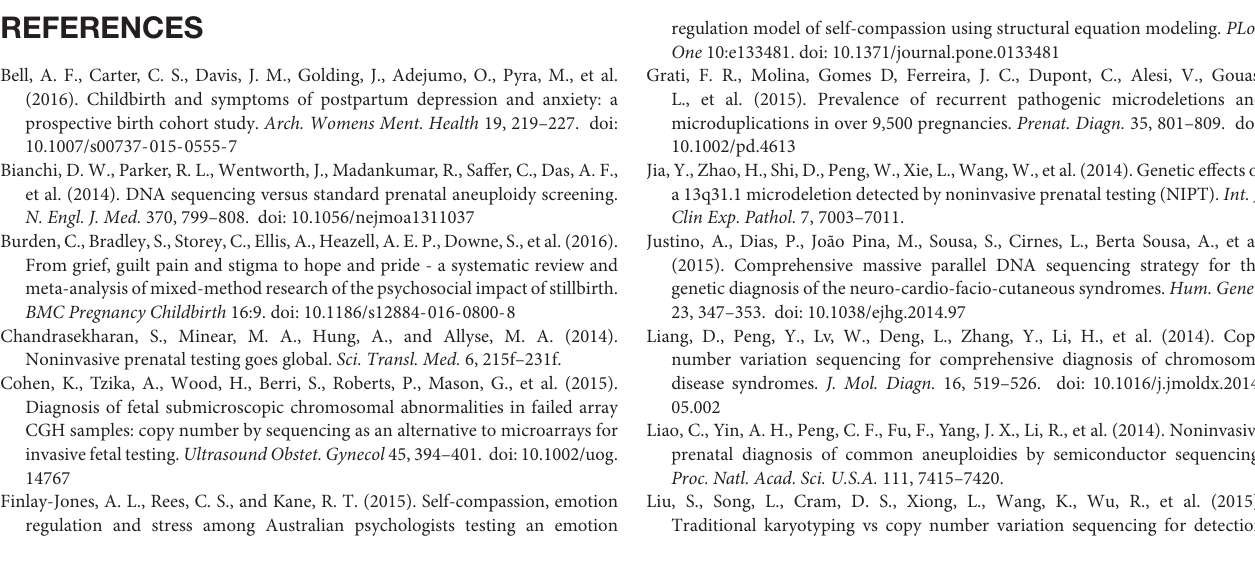
Supplementary Table 1 | Patient data for NIPT. Supplementary Table 2 | Patient data for